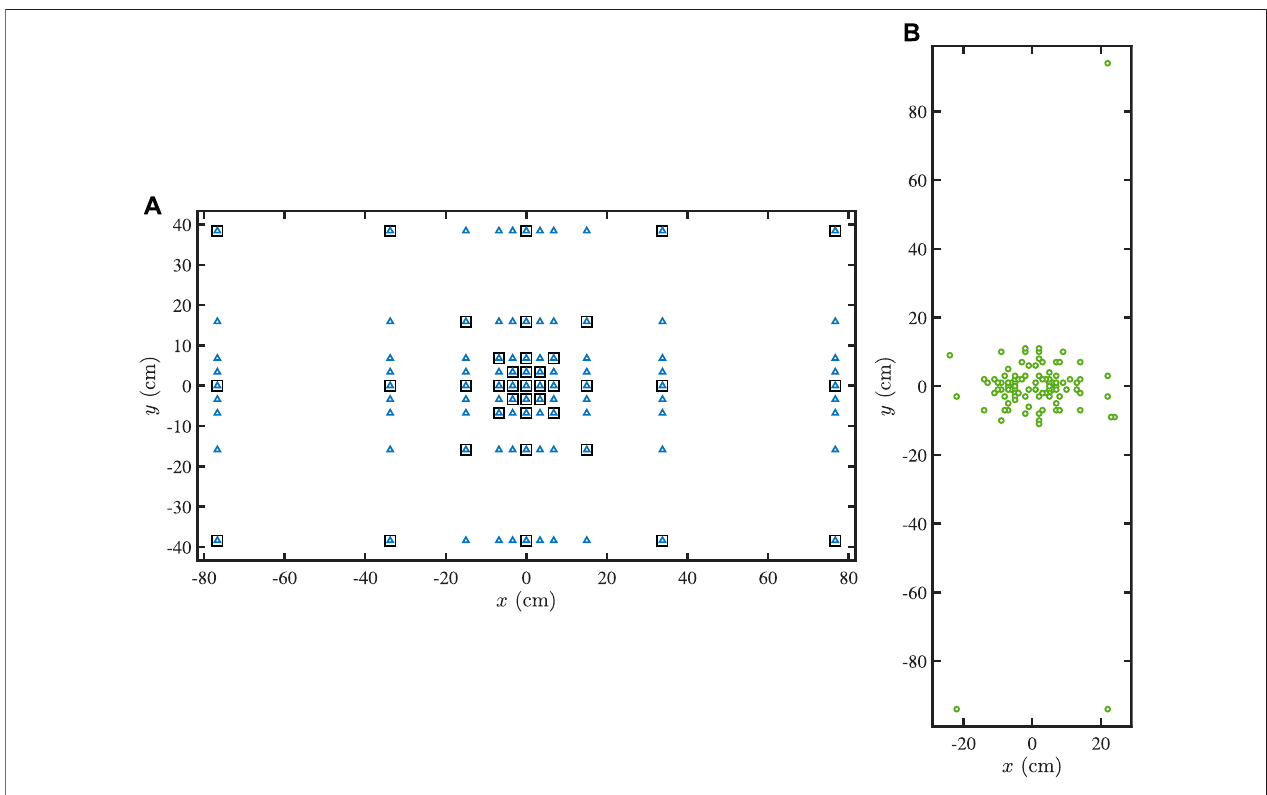
FIGURE 8 | (A) Con fi gurations of the arrays: proposed planar (triangles) and proposed star (squares). (B) Con fi guration of Son ’ s array (circles).